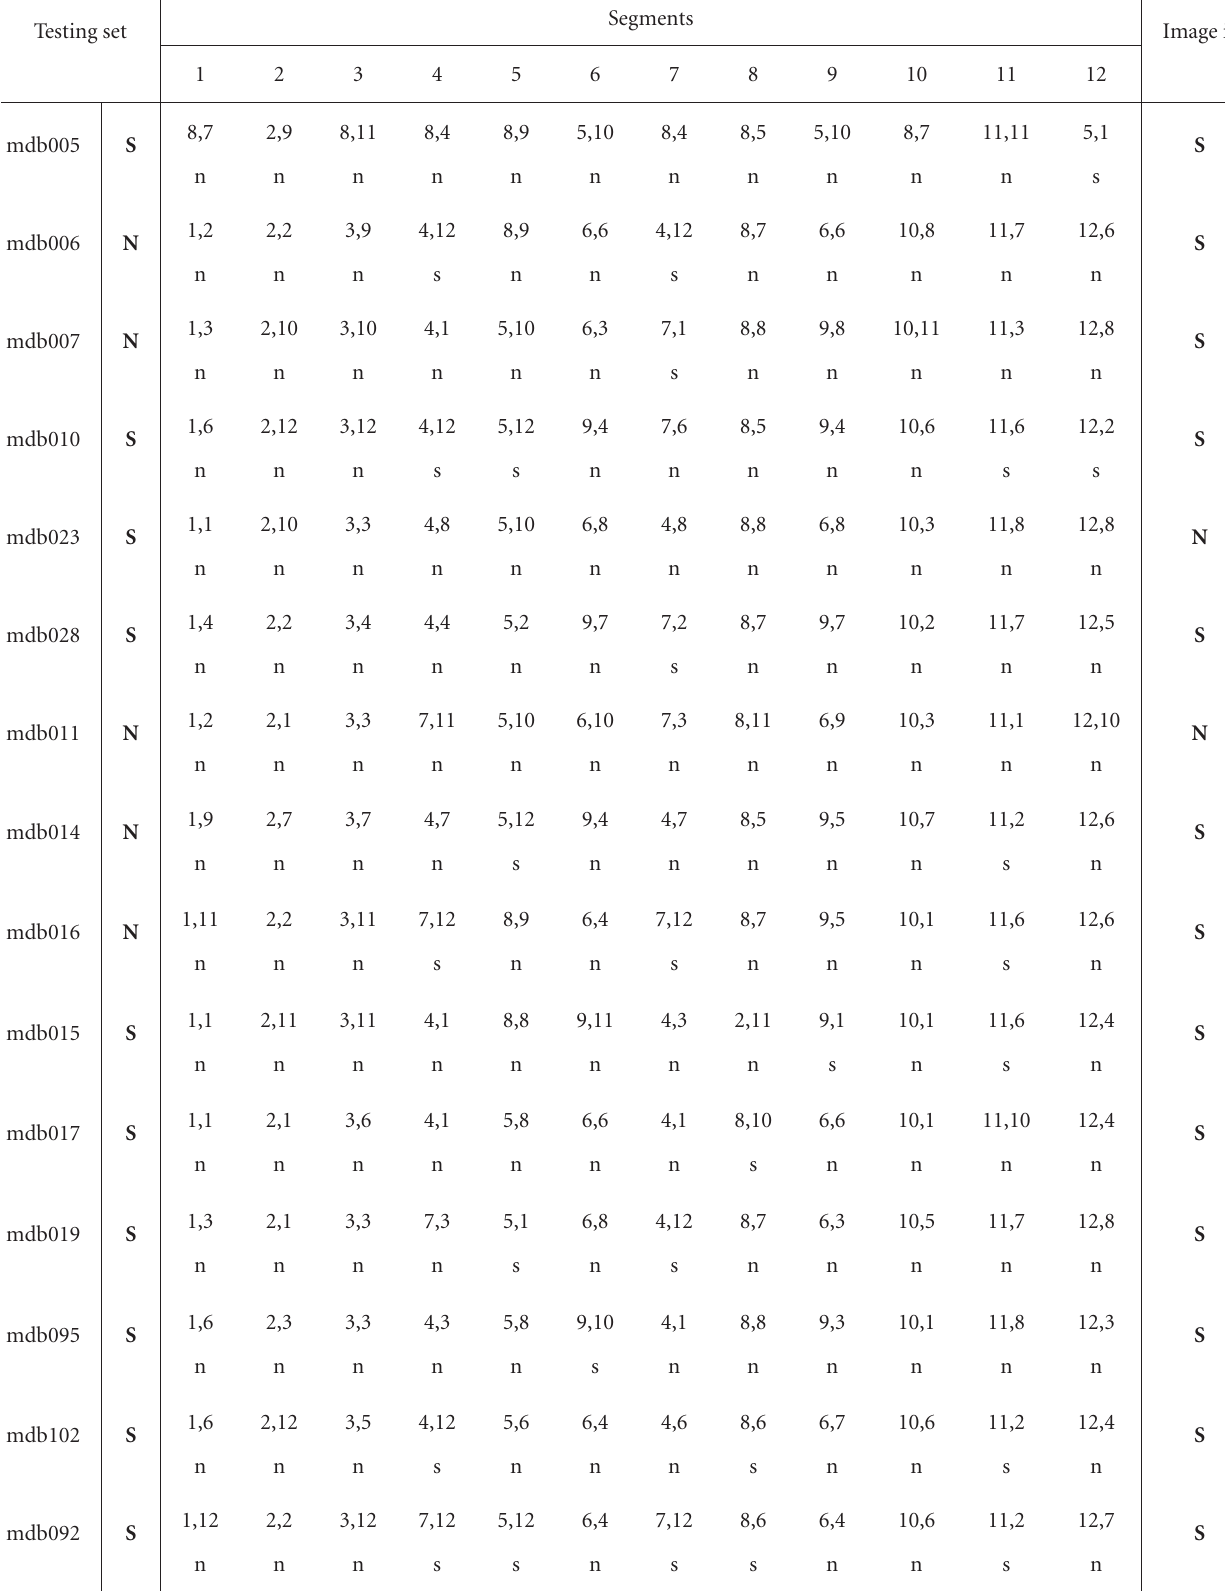
Table 5: Results of using curvilinear modeling and PCA with Chebyshev distance. Note: first number indicates the block number and second one signifies the image number in training